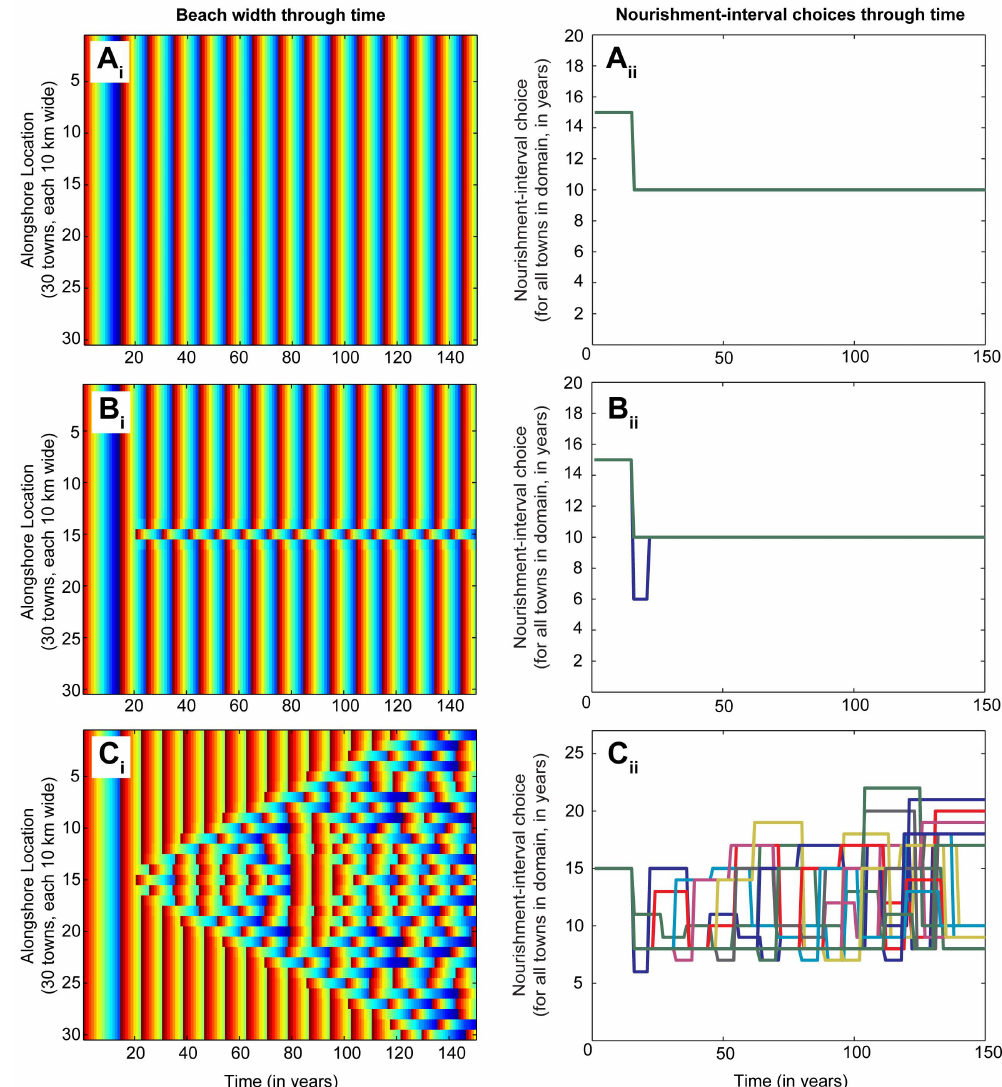
Fig. 2. Beach width (i) and nourishment-interval choice (ii) plotted through time for three example scenarios. Color in (i) indicates beach width, wide (reds) to narrow (blues). In (a) , τ is homogenous over the whole domain. The effect of forcing the middle town to nourish out of turn differs depending on external forcing conditions: (b) shows beach width and τ through time for γ r = 0.5myr − 1 ; (c) shows the onset of instability if background erosion is increased to γ r = 1.5myr − 1